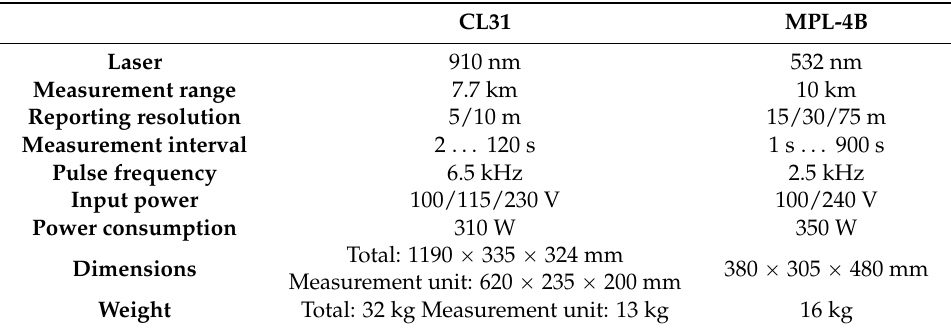
Table 1. Parameters of the CL31 and